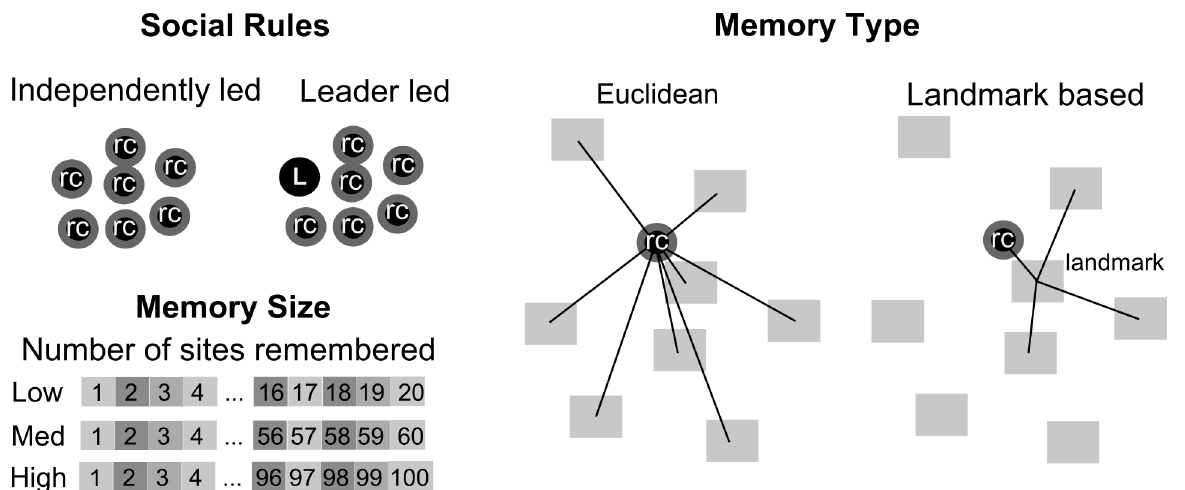
Figure 1. Simulated primate agents (dots), each representing a foraging hypothesis examining the effects of group social rules, memory type, and amount of memory on foraging